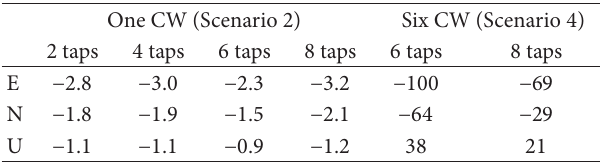
Table 10: Position errors in the presence of distortions for different TDLs: for one CW and six CW (in